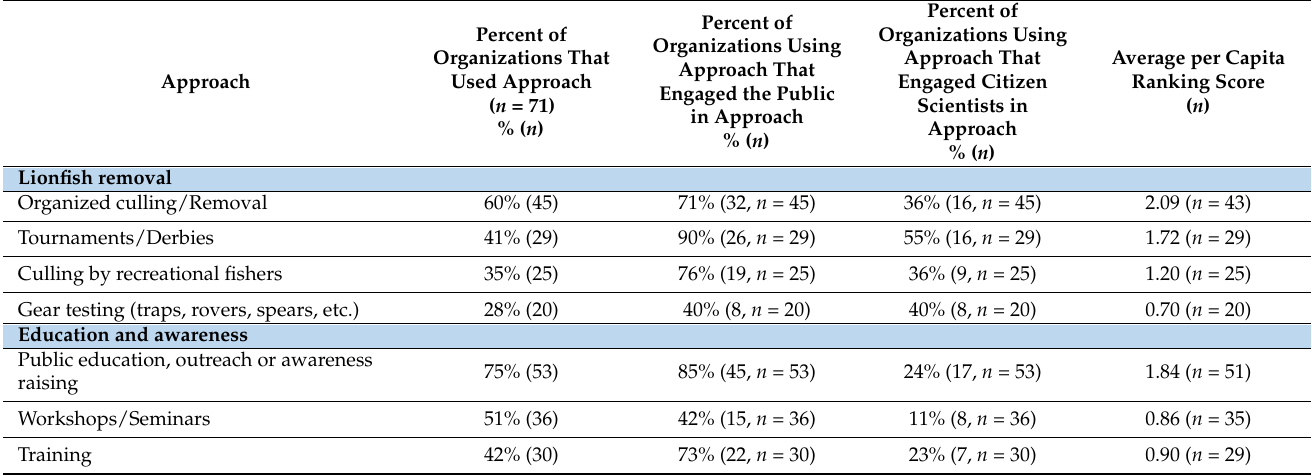
Table 1. Types of approaches directly implemented by organizations for lionfish control alongside their average per capita ranking score, the number of organizations who have used the approach, and the percent of organizations that have engaged the public or citizen scientists in the